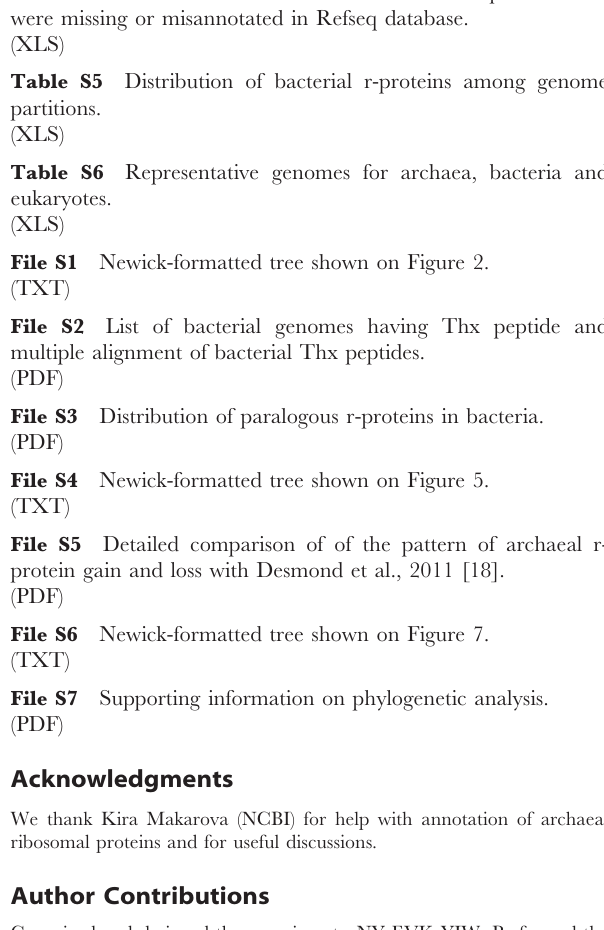
Table S1 List of r-proteins analyzed in this study. Table S2 List of bacterial and archaeal genomes analyzed in this study. Table S3 Phyletic distribution of ribosomal proteins collected in this study. Table S4 List bacterial and archaeal ribosomal proteins that were missing or misannotated in Refseq database. Table S5 Distribution of bacterial r-proteins among genome partitions. Table S6 Representative genomes for archaea, bacteria and